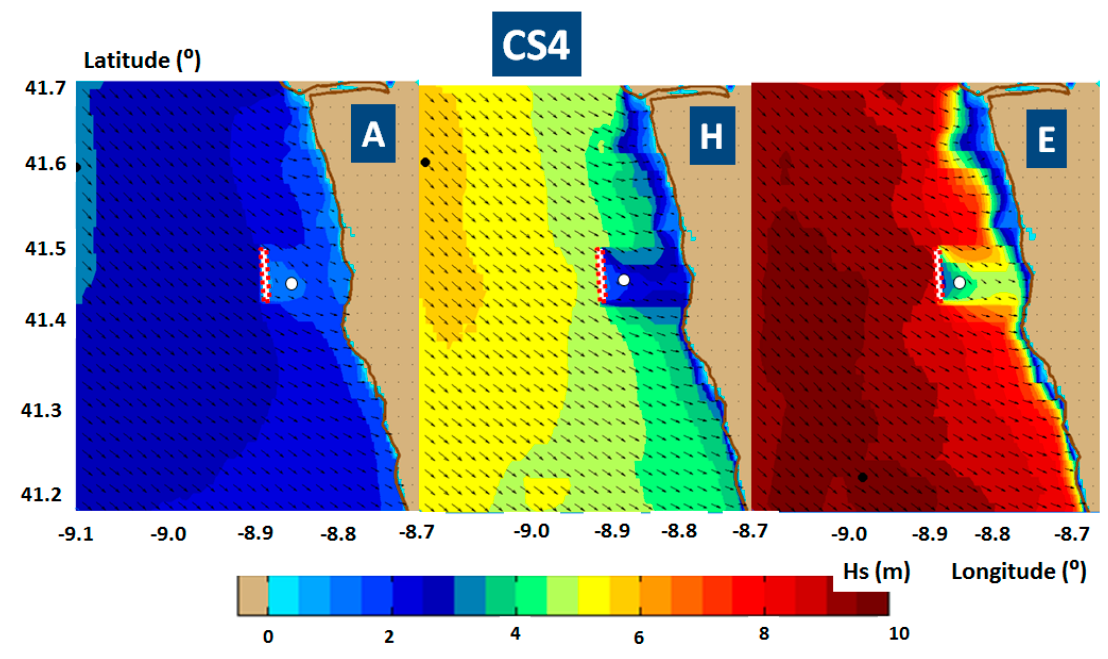
Figure 10. CS4 (multi-line scenario for the wave farm), results of the SWAN model simulations. The significant wave height scalar fields are represented in the background, while in the foreground the wave vectors. A—average wave conditions, H—high wave conditions, E—extreme wave conditions.